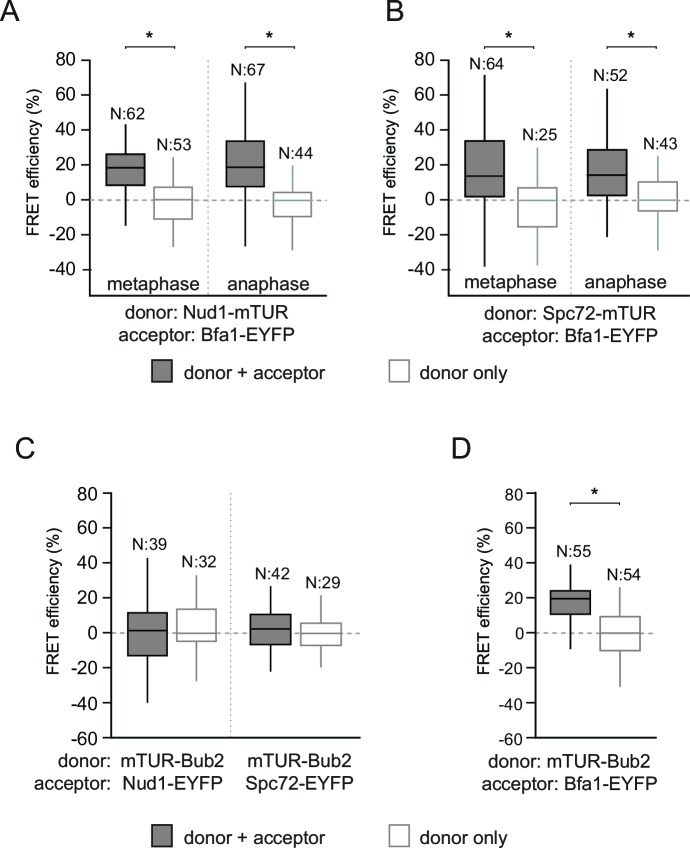
FRET analysis of Bfa1 and Bub2.(A–B) FRET efficiencies of Bfa1-Nud1 (A) and Bfa1-Spc72 (B) in metaphase and anaphase arrested cells. Metaphase arrest is achieved by Cdc20 depletion (Gal1-CDC20) and anaphase arrest was induced by overproduction of nondegradable Clb2 (Gal1-CLB2ΔDB). (C–D) FRET efficiency of mTUR-Bub2 with Nud1-EYFP and Spc72-EYP (C) or with Bfa1 C-terminal fusion (D). Box-whisker plots in C and D are one out of two technical replicates from the same experiment. N: sample size. Asterisks show significant difference according to student’s t-test (p<0.01). See the accompanying data file for exact p-values (Figure 2—figure supplement 1—source data 1–4).DOI:
http://dx.doi.org/10.7554/eLife.14029.01310.7554/eLife.14029.014Figure 2—figure supplement 1—source data 1.Raw and calculated FRET efficiencies of the Bfa1-Nud1 pair in metaphase and anaphase arrested cells (source data for Figure 2—figure supplement 1A).DOI:
http://dx.doi.org/10.7554/eLife.14029.01410.7554/eLife.14029.015Figure 2—figure supplement 1—source data 2.Raw and calculated FRET efficiencies of the Bfa1-Spc72 pair in metaphase and anaphase arrested cells (source data for Figure 2—figure supplement 1B).DOI:
http://dx.doi.org/10.7554/eLife.14029.01510.7554/eLife.14029.016Figure 2—figure supplement 1—source data 3.Raw and calculated FRET efficiencies of Bub2-Nud1 and Bub2-Spc72 pairs in cycling cells (source data for Figure 2—figure supplement 1C).DOI:
http://dx.doi.org/10.7554/eLife.14029.01610.7554/eLife.14029.017Figure 2—figure supplement 1—source data 4.Raw and calculated FRET efficiencies of Bub2-Bfa1 pair in cycling cells (source data for Figure 2—figure supplement 1D).